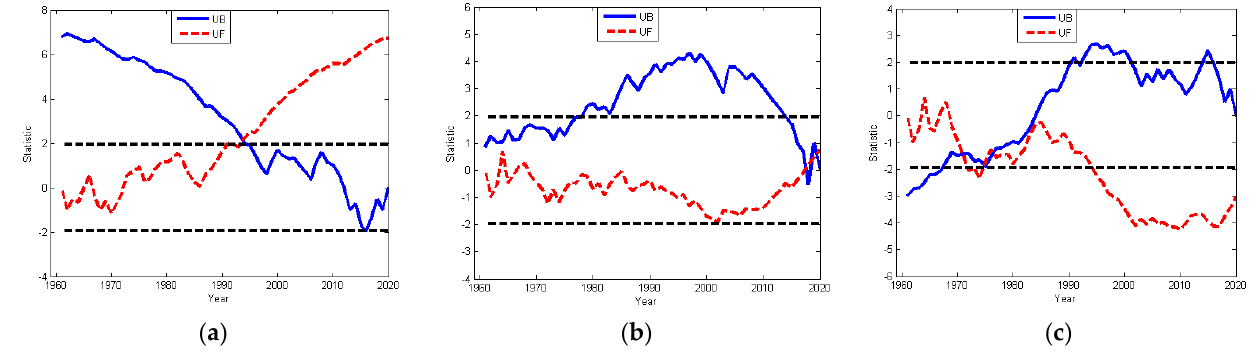
Figure 4. M-K statistical curves of annual mean temperature: ( a ) annual total precipitation, ( b ) annual natural runoff, and ( c ) ( the black dotted line is the critiacl level of significant α = 0.05).